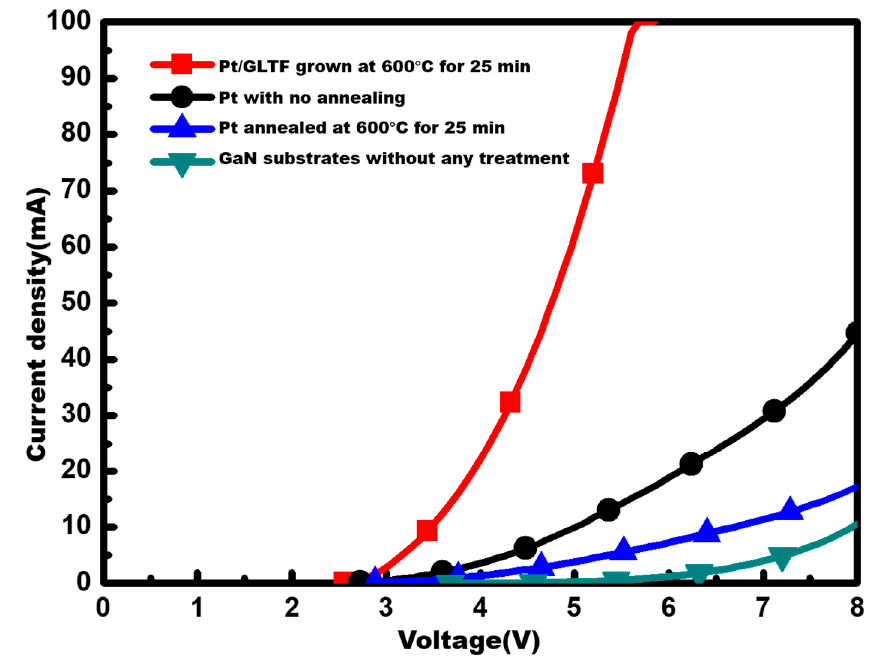
Figure 4. A current–voltage (I–V) curve comparison of the LED devices of GaN substrates without any treatment, with Pt film, with annealed Pt film, and with Pt-GLTF film.